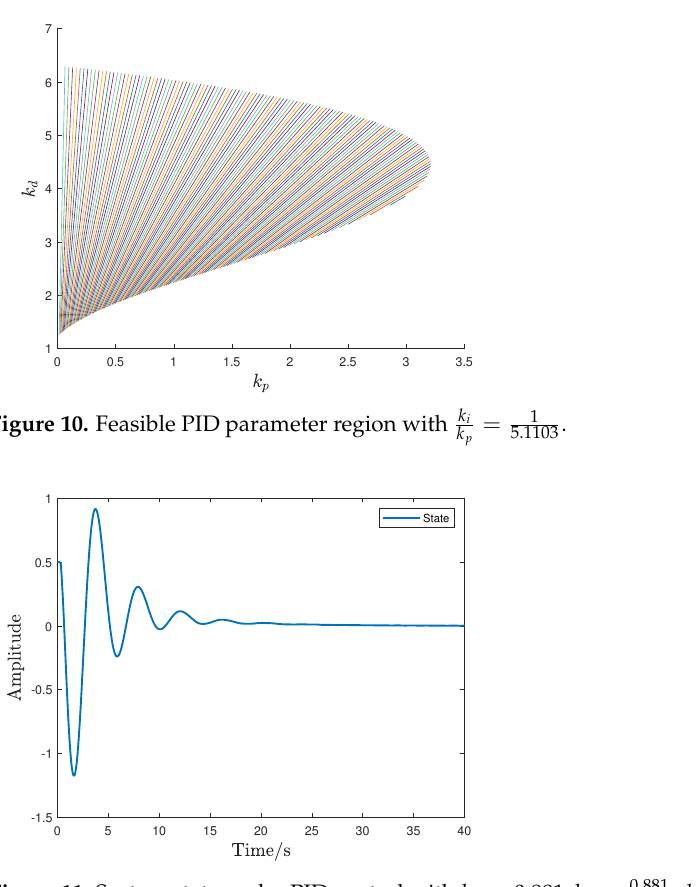
, k d = 3.013. 5.1103 = 4 and k i = 7, respectively. It k p k p